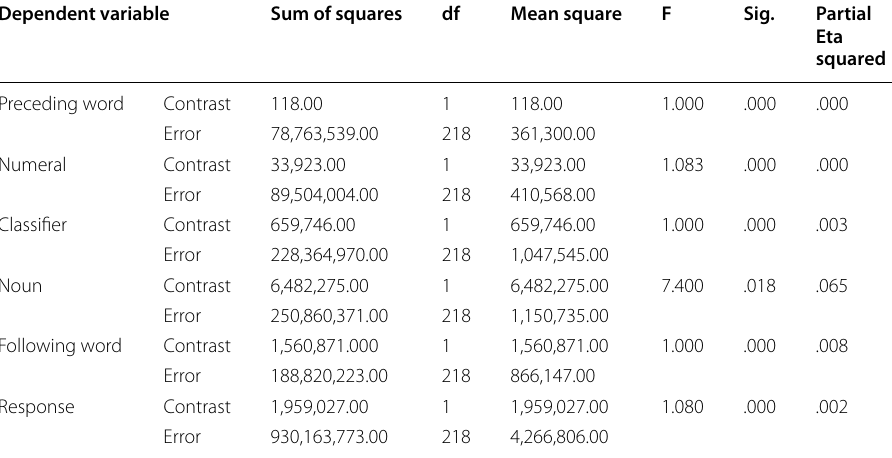
Table 5 Univariate analysis (the effect of sentence type)